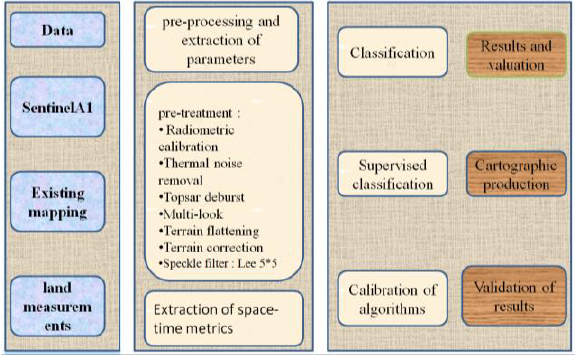
Figure 4. Sentinel 1 SAR image processing methodology